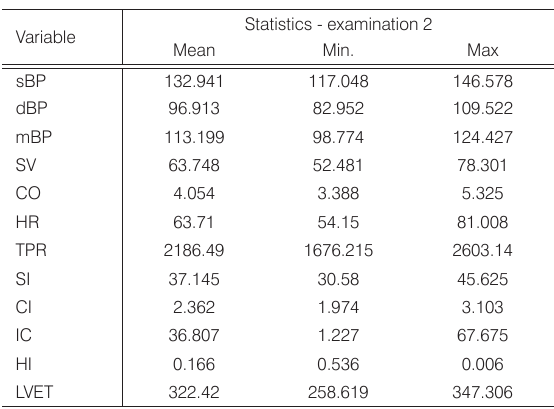
Table 6. Descriptive statistics of parameters: sBP, dBP, SV, CO, HR, SI, CI, IC, HI, LVET and TPR (Examination 2).